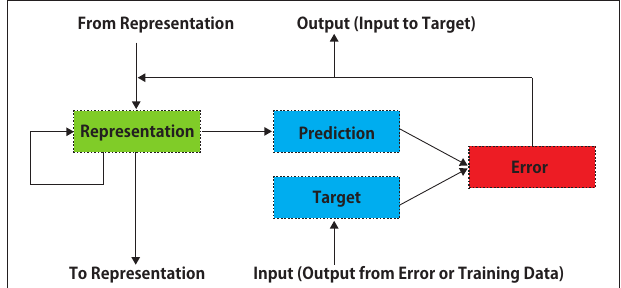
FIGURE 1 | A schematic diagram of PredNet (a modification of Figure 1 in Lotter et al., 2016). Illustration of information flow within a single layer is presented. Vertical arrows represent connections with other layers. Each layer consists of “Representation” neurons, which output a layer-specific “Prediction” at each time step, which is subtracted from “Target” to produce an error, which is then propagated laterally and vertically in the network. External data or a lower-layer error signal is input to “Target.” In each layer, the input information is not processed directly, and the prediction error signal is